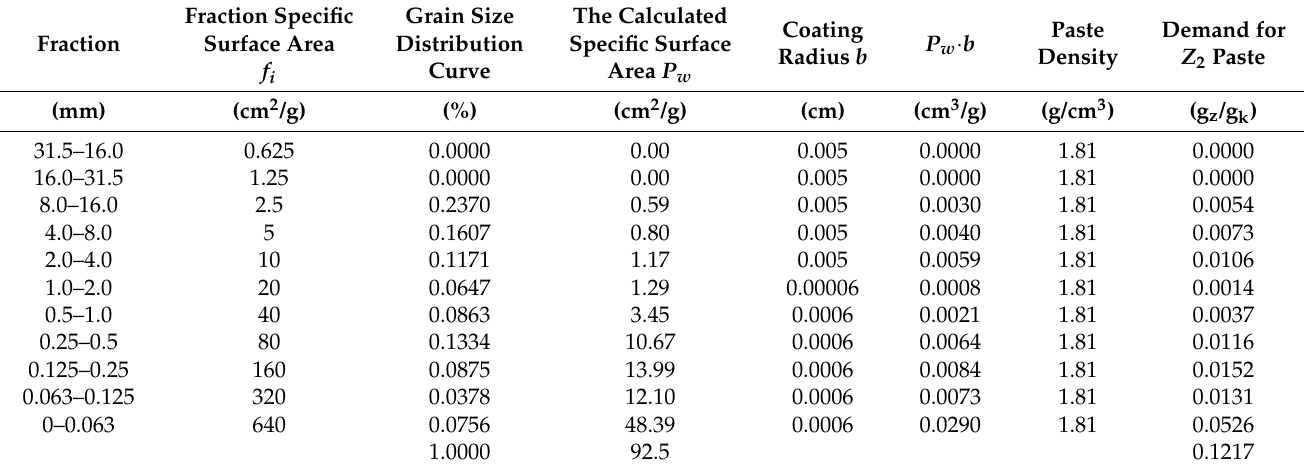
Table 11. Determining the demand for Z 2